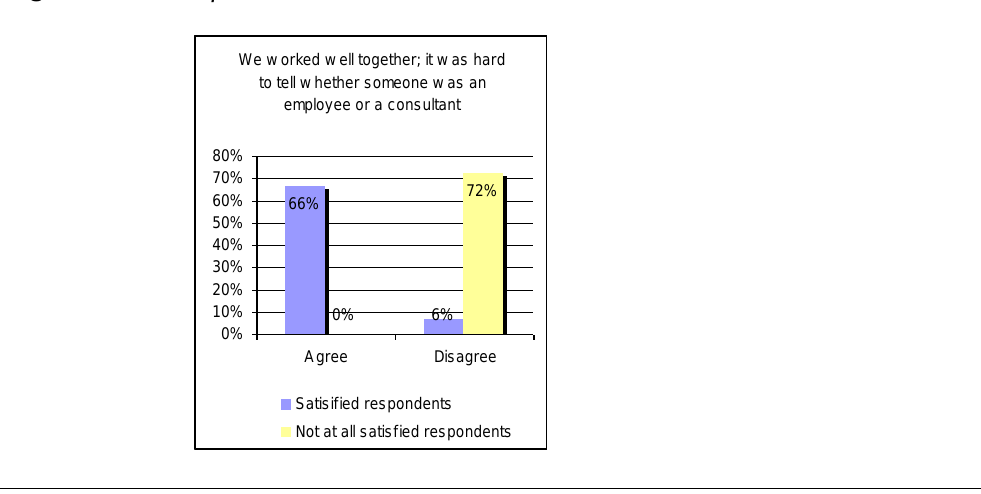
Figure 5: The Importance of Team